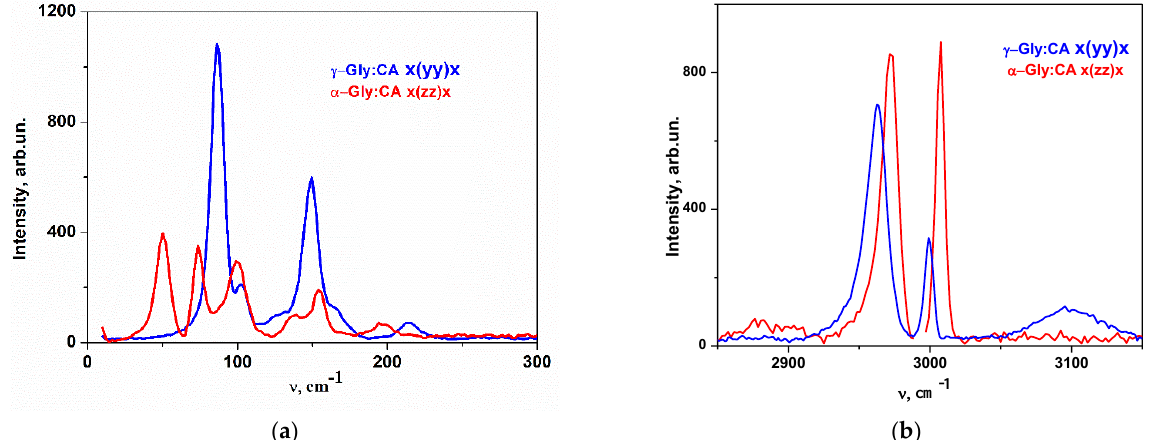
Figure 5. Comparison of Raman spectra of Gly:CA crystals of pyramidal (blue line) and plate-like (red line) shapes in low-energy ( a ) and high-energy ( b ) spectral regions.